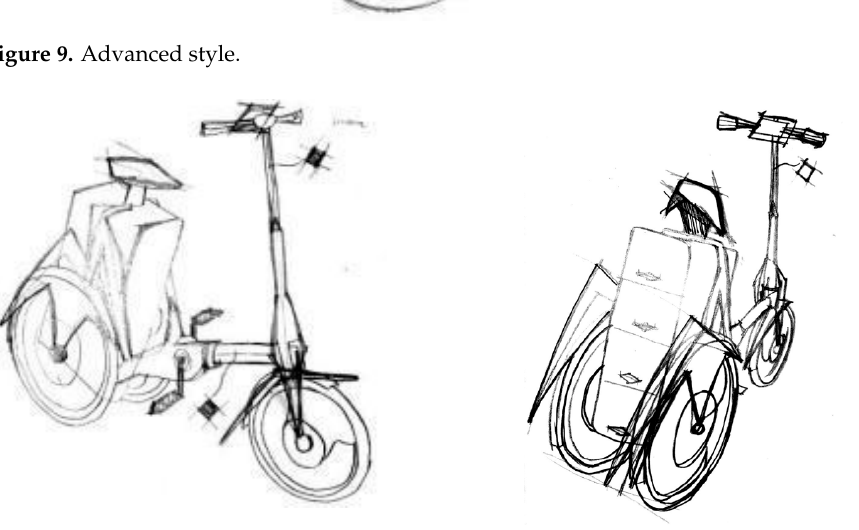
Figure 10. Stone style.